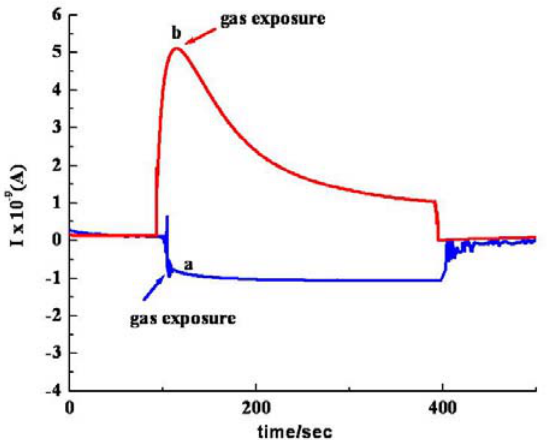
Figure 8. Response profile obtained at room temperature for (a) neat Nylon nanofibers based device, (b) sa MWCNT/Nylon-6 nanofibers based device when exposed to acetone